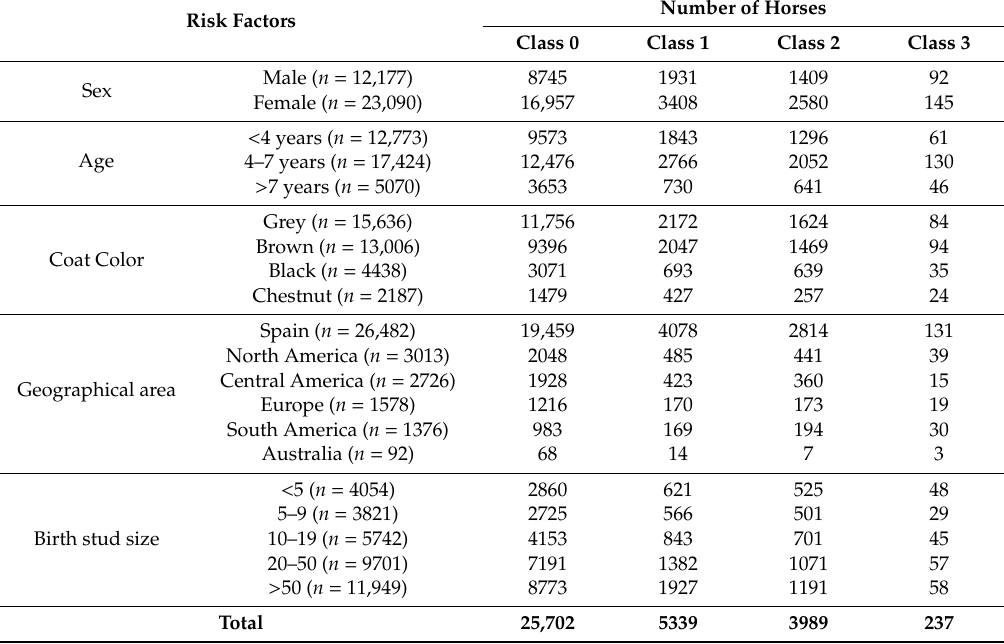
Table 3. Number of Pura Raza Español horses according to its Ewe Neck score class, depending on di ff erent risk factors.